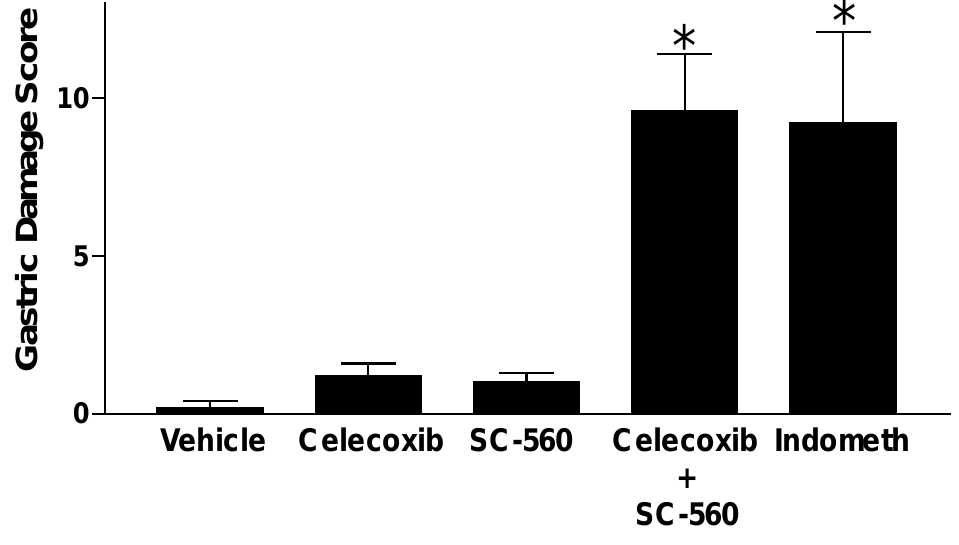
FIGURE 2 . Combined inhibition of COX-1 and COX-2 is necessary for NSAID-induced gastric damage. Severity of gastric damage induced in the rat by administration of selective inhibitors of COX-2 (celecoxib; 15 mg/kg), COX-1 (SC-560; 40 mg/kg), or a nonselective COX inhibitor (indomethacin; 5 mg/kg). Asterisks indicate a significantly greater degree of damage than was observed with the vehicle ( p < 0.05). Further details of these experiments can be found in Wallace et